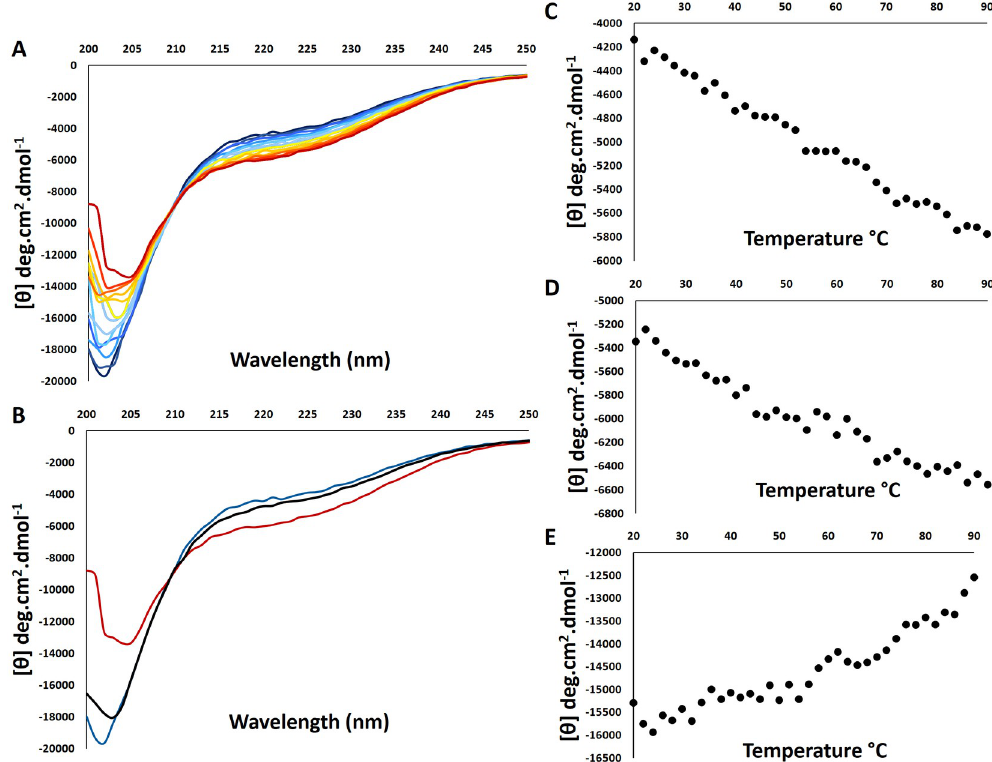
Fig 7. Far-UV circular dichroism monitoring of thermal unfolding of RBBP6 p53BD. (A) : Far UV CD spectrum for the RBBP6-p53BD from 20˚C and 90˚C (dark blue to dark red). (B) : Spectrum for the RBBP6-p53BD in the native state (blue), when heated to 90˚C (red) and cooled back to 20˚C (black). The heat unfolding curves for the RBBP6-p53BD at (C) : 222nm, (D) : 215nm, and (E) : 208nm between 20˚C and 90˚C.